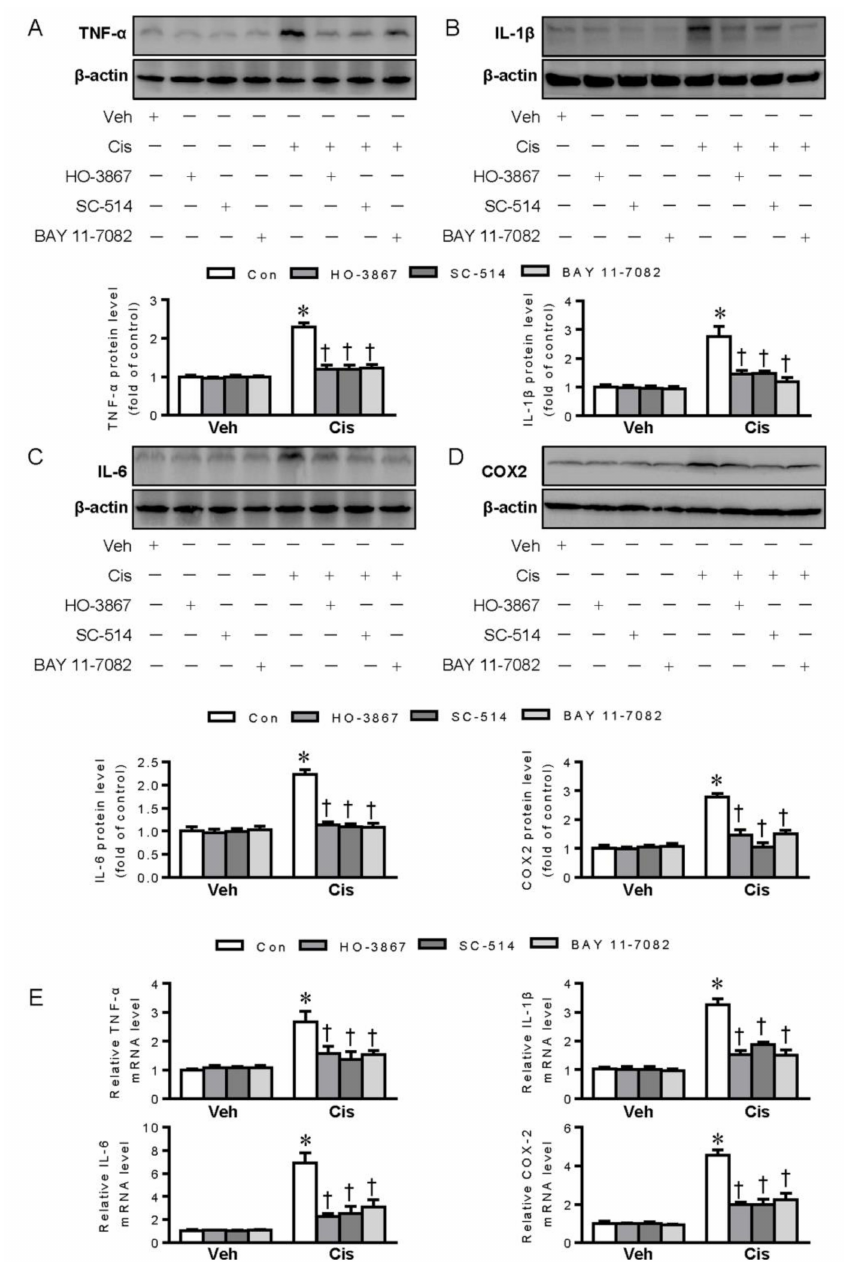
Figure 3. Pharmacological inhibition of STAT3, IKK β , and NF- κ B with their specific inhibitors prevented cisplatin (Cis)-induced inflammation in renal tubular cells. ( A – D ) Representative blots and quantitative analysis of TNF- α , IL-1 β , IL-6, and COX-2. ( E ) Relative mRNA levels of TNF- α , IL-1 β , IL-6, and COX-2. * p < 0.05 vs. Vehicle (Veh), † p < 0.05 vs. Control (Con). Cisplatin (Cis). n = 4–6 in each